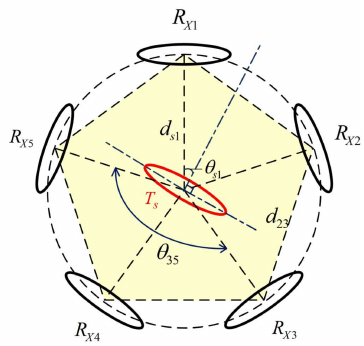
Figure 4. A simplified diagram of the multi-receiver